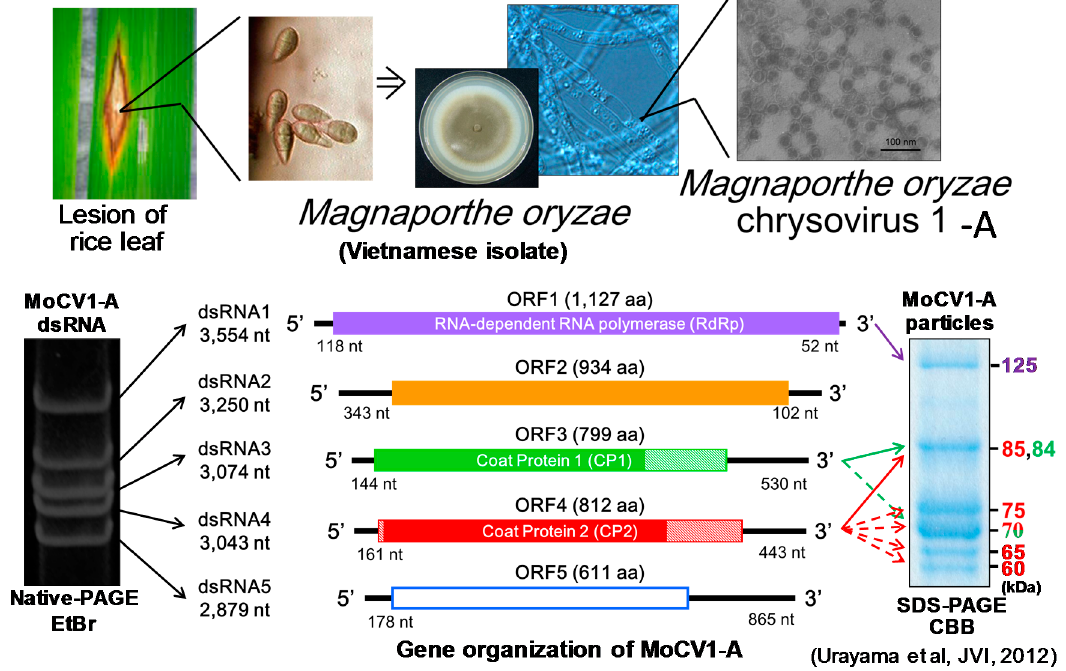
Figure 4. Isolation and analysis of mycovirus MoCV1-A from the rice blast fungus, M. oryzae . Upper panels, process of isolation and purification of the mycovirus. Lower left, dsRNA genomic segments extracted from purified MoCV1-A virus particles were subjected to 5% ( w / v ) native PAGE. Lower middle, open reading frames (ORFs) within each of the five genomic segments. Lower right, MoCV1-A viral proteins were separated by denaturing PAGE.